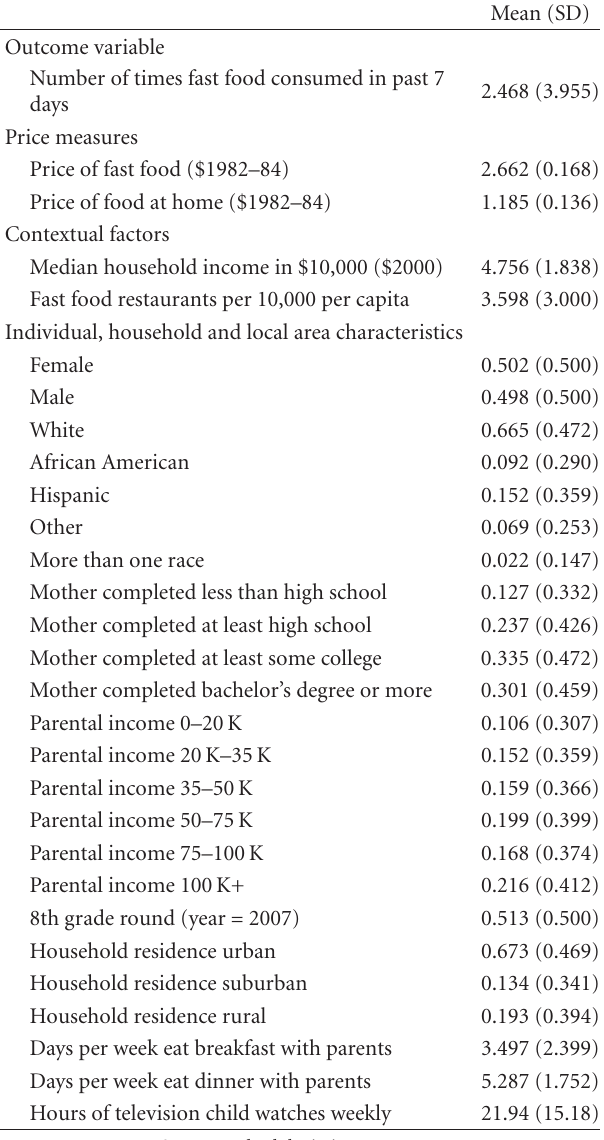
Table 1: Summary